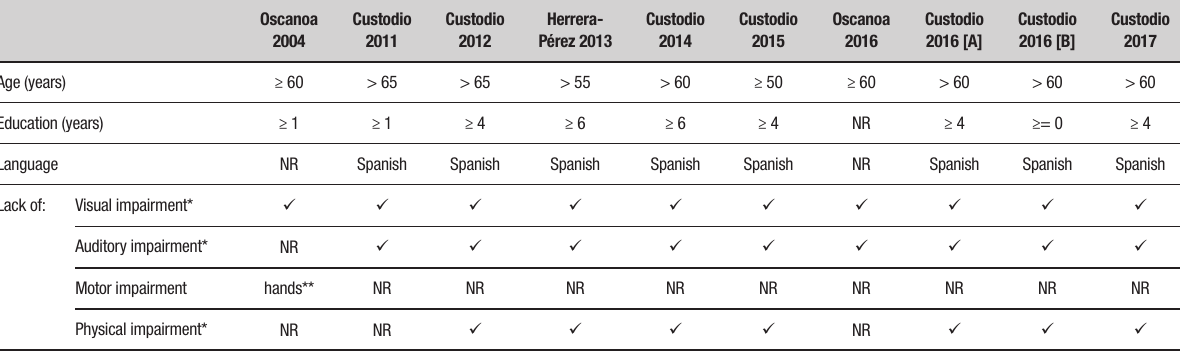
Table 2. Study eligibility criteria.